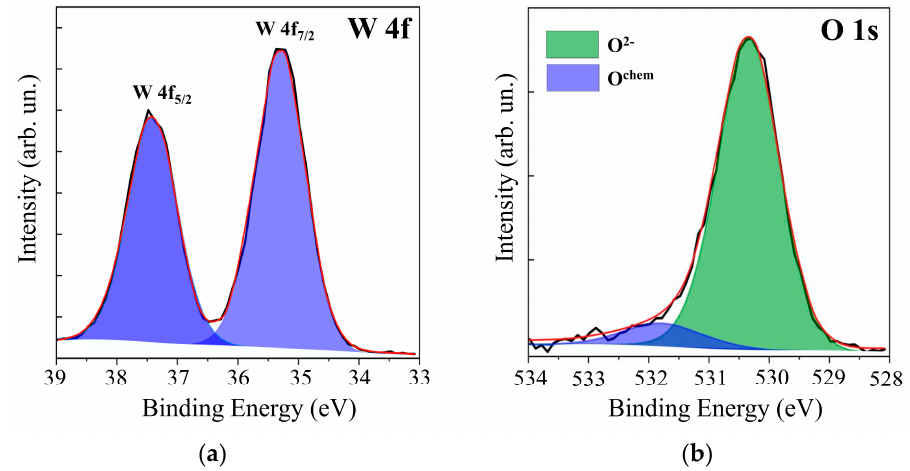
Figure 2. XPS ( a ) W 4f and ( b ) O 1s spectra for the surface of WO y film, which was obtained by RPLD at a dry air pressure of 40 Pa.